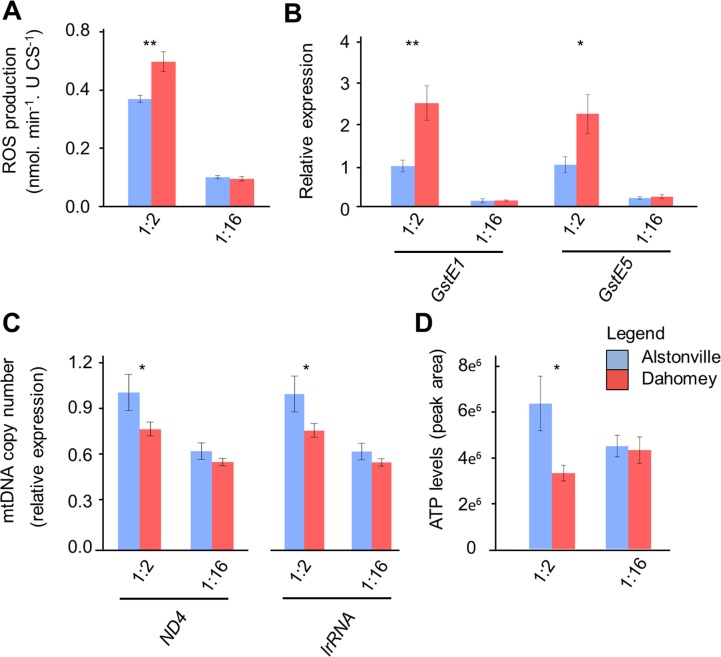
Basal ROS, antioxidant expression, mtDNA copy number and ATP levels Alstonville larvae had an advantage when fed the 1:2 P:C diet as the V161L ND4 amino acid change in complex I of Dahomey reduced the efficiency of ATP production.(A) Measurement of basal ROS shows higher levels in Dahomey fed the 1:2 P:C diet. ROS levels were similar when larvae were fed the 1:16 P:C diet (n = 9 biological rep/mitotype on the 1:2 P:C diet, and 8 biological rep/mitotype on the 1:16 P:C diet with 2 failed reactions in Alstonville). (B). GstE1 and GstE5 expression was highest in Dahomey larvae fed the 1:2 P:C diet (n = 6 biological rep/mitotype/diet for both genes). (C) Alstonville larvae had higher mtDNA copy number when fed the 1:2 P:C diet but both mitotypes had equivalent and lower copy number when fed the 1:16 P:C diet. MtDNA copy number show the relative expression of ND4 (ND4/Actin) and lrRNA (lrRNA/Rp49) (n = 8 biological rep/mitotype/diet with 2 failed reactions for ND4/Actin and 7 biological reps/mitotype/diet for lrRNA/Rp49 with 2 failed reactions). (D) Total cellular ATP levels were higher in Alstonville larvae fed the 1:2 P:C diet but were similar when fed the 1:16 P:C diet suggesting a mitohormetic response (n = 8 biological rep/mitotype/diet, with two failed reactions) Bars show mean± s.e.m. t-tests between mitotypes * p< 0.05, ** p< 0.01 (see text).